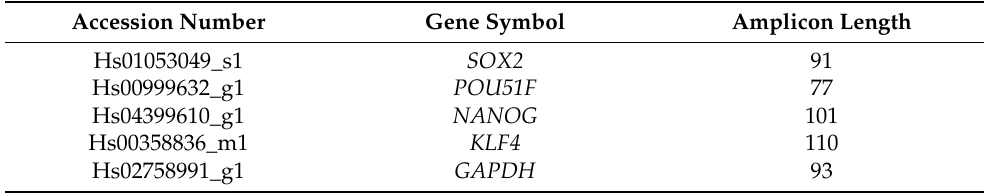
Table 2. List of Taqman ® Gene Expression